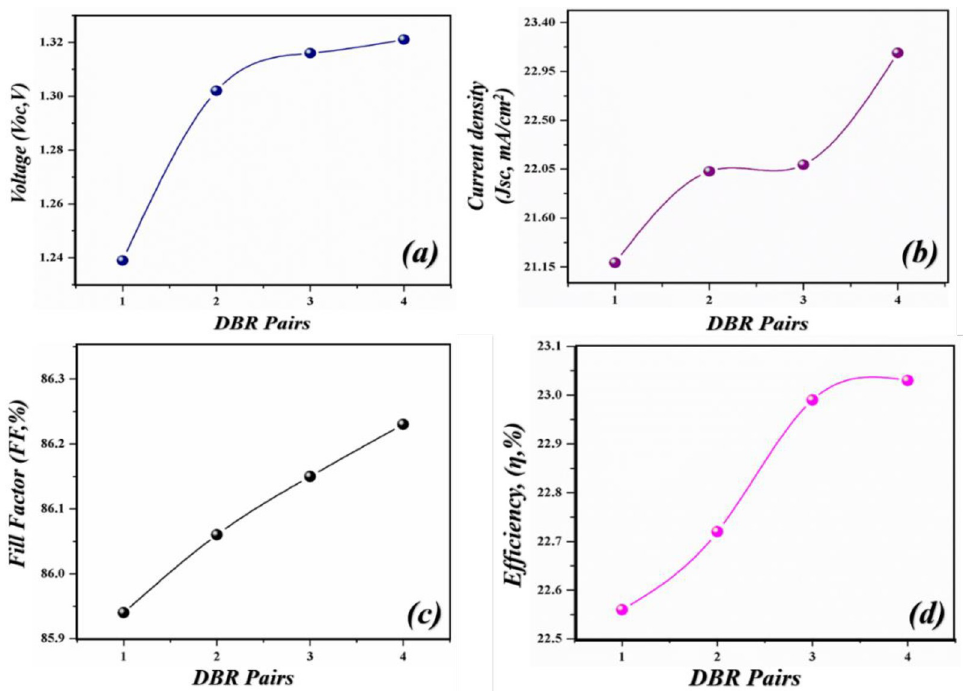
Fig 8. Simulated photovoltaic parameters of novel geometry with different DBR pairs (Si/SiO 2 ) (a) V oc as an as an independent function of the light-harvesting layer (c) FF as independent function of light-harvesting layer, (b) J sc an independent function of light-harvesting layer (d) PCE as an independent function of light-harvesting layer.